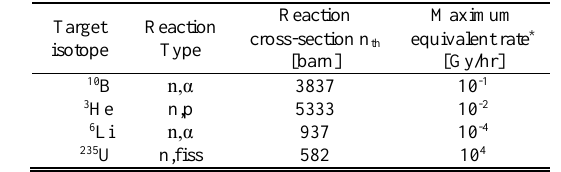
Fig. 4 – Microscopic reaction rates related to different detectors, using 239 PuBe neutron source, calculated in SERPENT2 [10]. T ABLE 3 - P ROPERTIES OF THE SELECTED THERMAL NEUTRON CONVERTER FOR NEUTRON DETECTION [18].